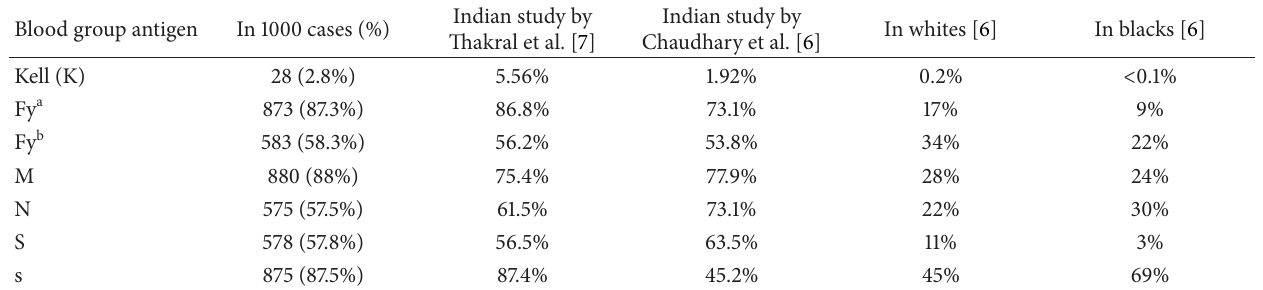
Table 3: Antigen frequency of clinically significant minor blood group antigens.